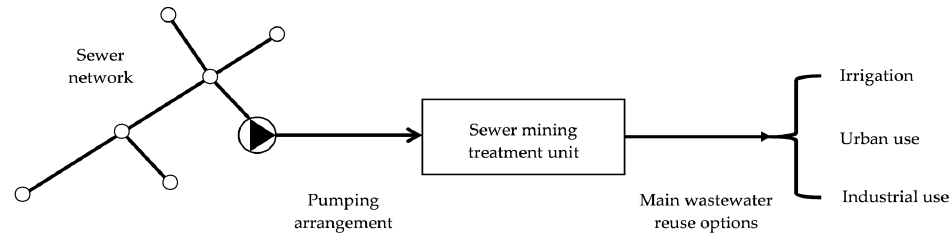
Figure 1. The basic concept of a sewer mining scheme (adapted from Makropoulos et al. [ 17 ]).